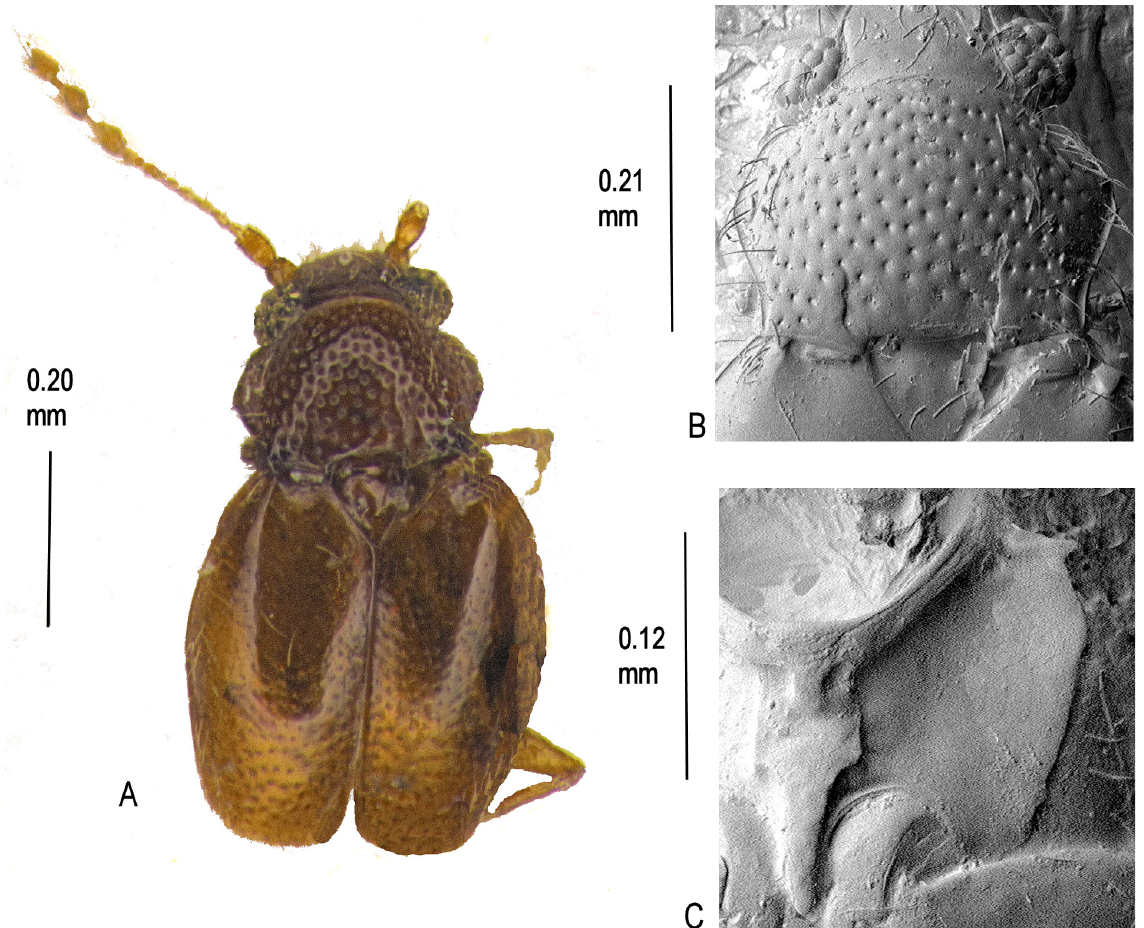
Fig. 48. Cissidium dewhurst sp. nov. A . Habitus. B . Pronotum, × 530. C . Mesoventrite showing median process of collar, mid-keel, keel and lateral margin,